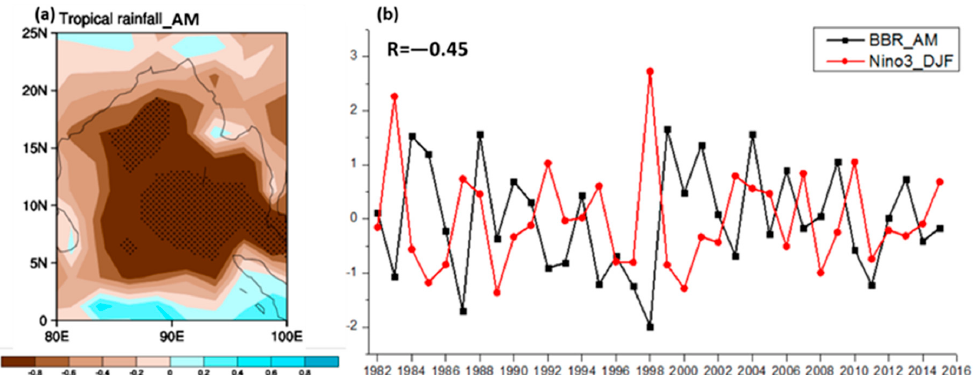
Figure 10. ( a ) composite anomalies of spring rainfall (unit: mm/day) over the Bay of Bengal in the EP El Niño years; ( b ) changes in the Bay of Bengal rainfall (BBR) (black squares) and Niño3 (red dots) index for the period 1982 to 2015. The dotted regions in ( a ) have the rainfall anomalies being statistically significant at the 0.1 level (i.e., p < 0.1) estimated by a local Student’s t -test. In Figure 10a, the composite anomalies of tropical rainfall over the BoB are indeed significantly negative during the EP El Niño years in springtime. We also define a BBR (Bay of Bengal rainfall) index, calculated from the regional mean rainfall over the BoB (85°–95°E, 5°–15°N), which exhibits